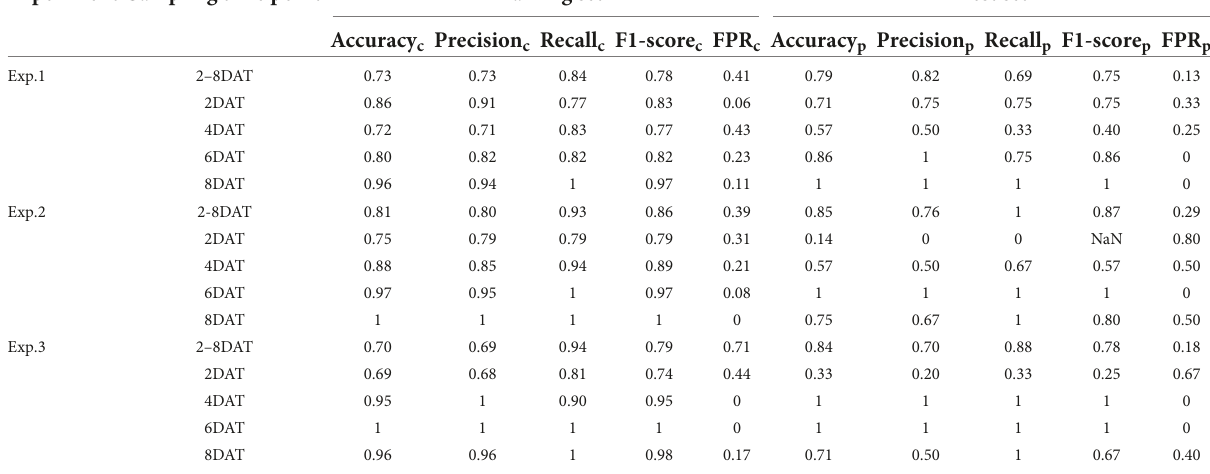
TABLE 1 Prediction results of support vector machine models in identifying glyphosate resistant cultivar. Experiment Sampling time point